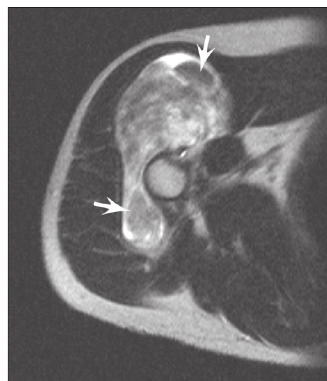
Figure 1b – Axial T2-weighted fast spin-echo MR image shows well-defined mass between deltoid and proximal humerus of heterogeneous signal intensity. Nodular high and low signal areas are seen